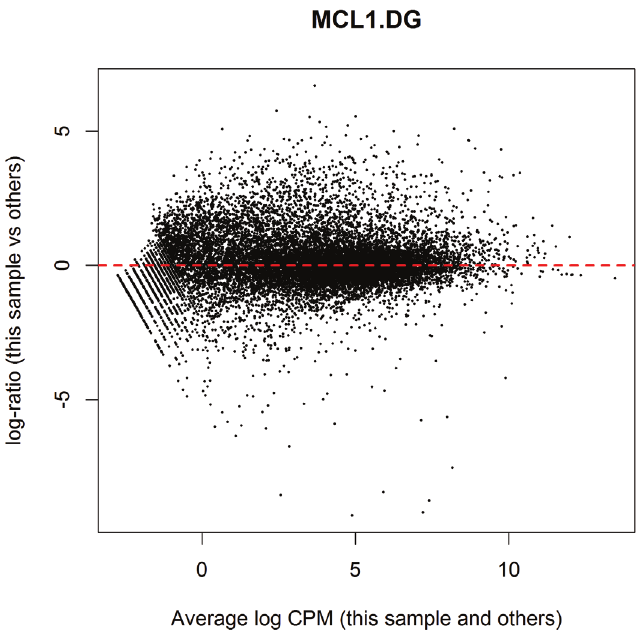
Figure 2. MD plot of log2-expression in sample 1 versus the average log2-expression across all other samples. Each point represents a gene, and the red line indicates a log-ratio of zero. The majority of points cluster around the red line.